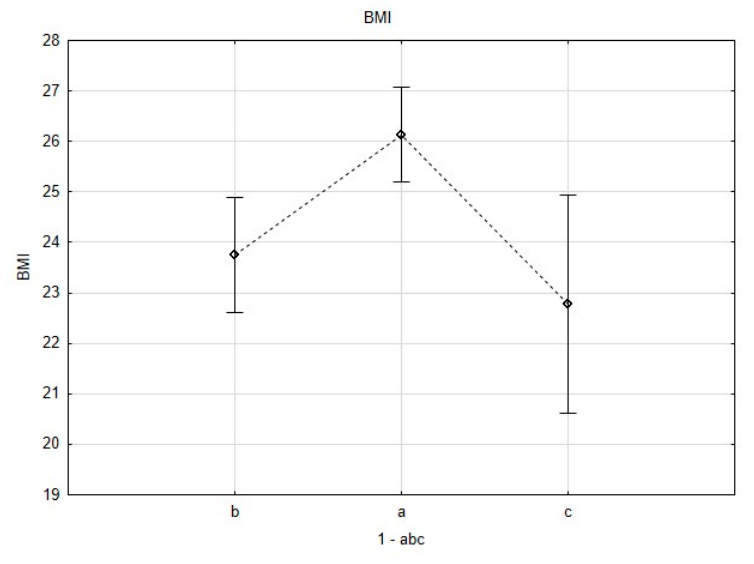
Figure 5. Significantly higher BMI scores (26.14 ± 4.03 vs. 23.75 ± 3.87) were observed in declared snorers (a) in comparison to non-snoring patients (b and c).